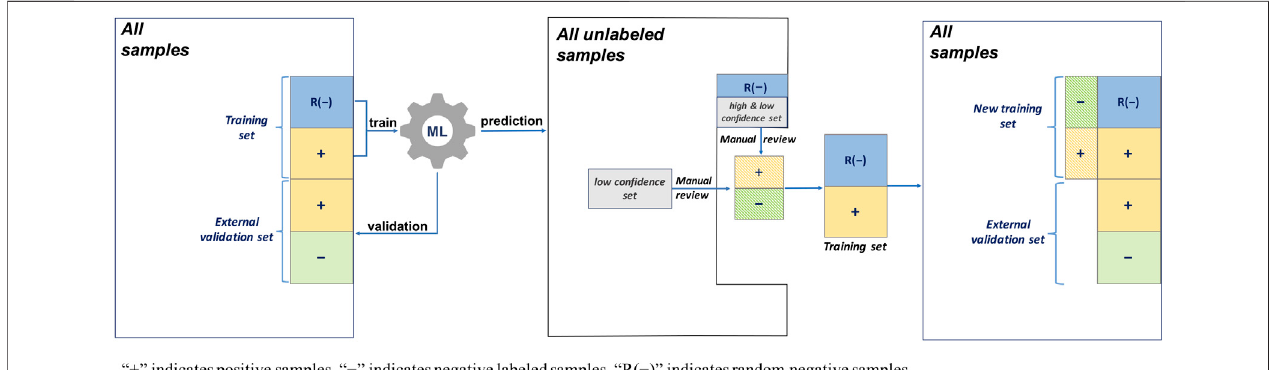
FIGURE4| Activelearningwork fl owwithasinglemachinelearning(ML)algorithm,uncertainty samplingplusrandomnegativesampling,andnovalidationupdate.